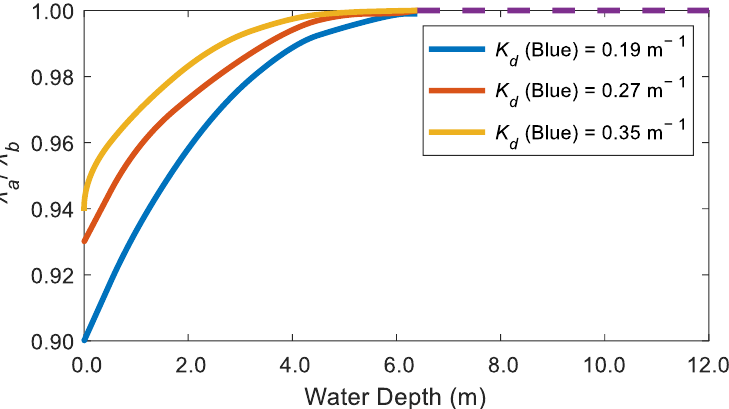
Figure 16. The ratio of the dominant wavelength of water after ( λ a ) and before ( λ b ) correction with the spatial method (with a 60-m tile size) against water depth from three locations. At depths > 6.4 m (purple dashed line), the dominant wavelength did not need correction.